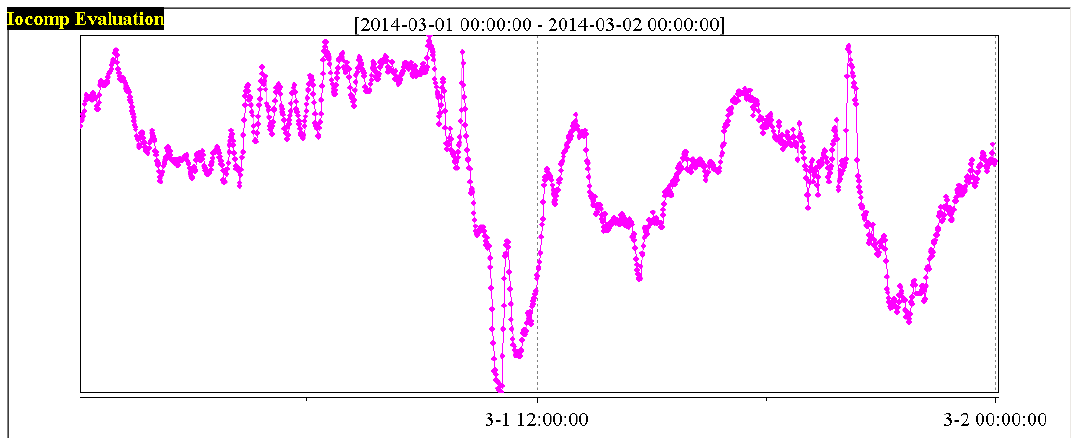
Figure 18. The carbon content of fly ash x 4 (%) (2# boiler).